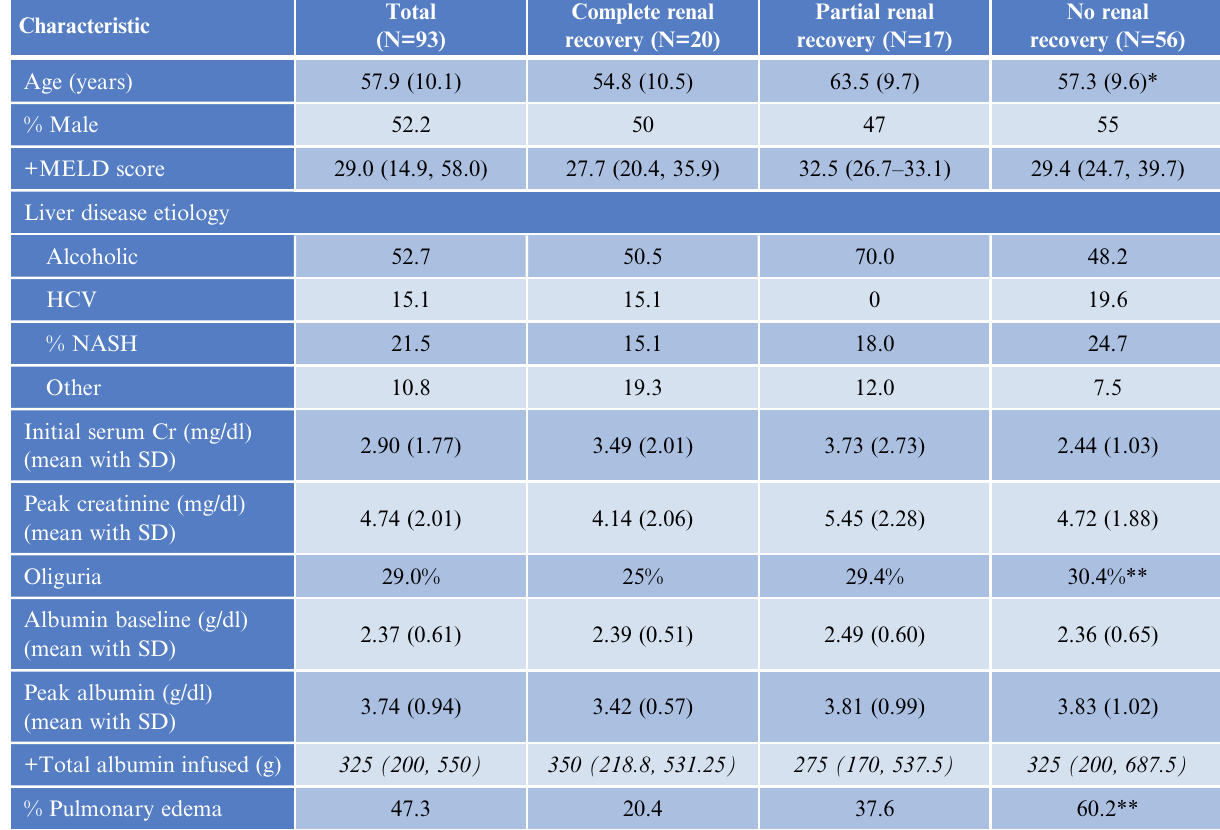
Table 1. Baseline characteristics of patients with hepatorenal disorders receiving intravenous albumin (n=93)